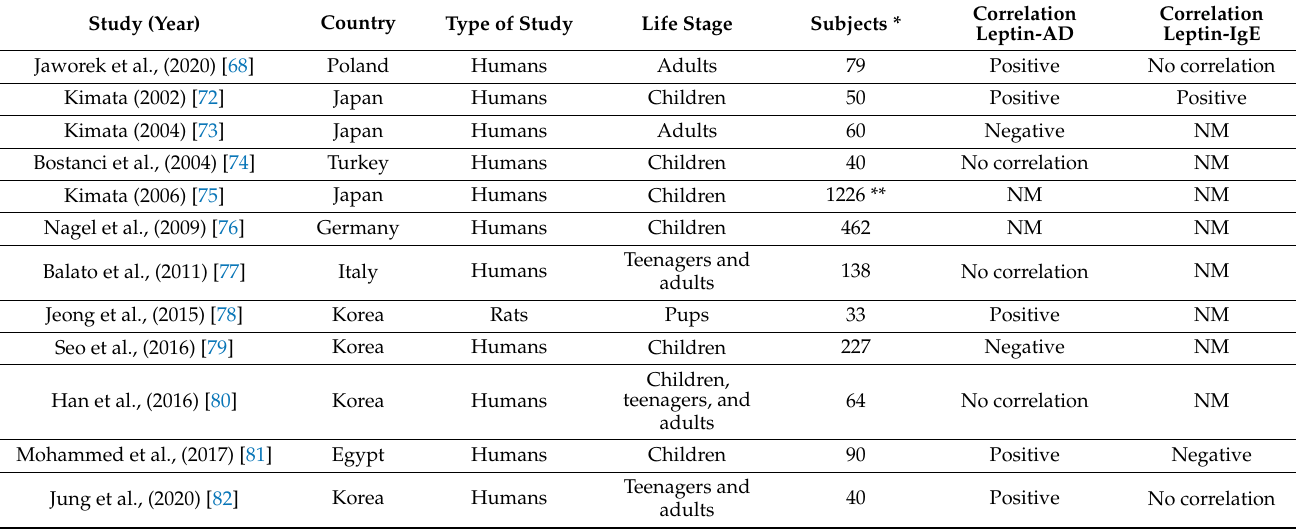
Table 1. Existing studies related to the role of leptin in atopic dermatitis (AD) and its possible relationship with IgE in the disease. NM: not measured (correlation analysis was not performed). No correlation: correlation analysis was performed but without statistically significant